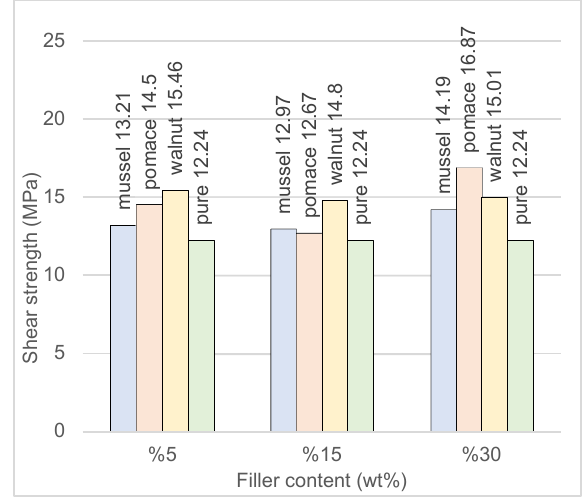
Figure 4. Average shear strengths of the 45 µm adhesive joints. Figure 7. Average shear strengths of the 45 µ m adhesive